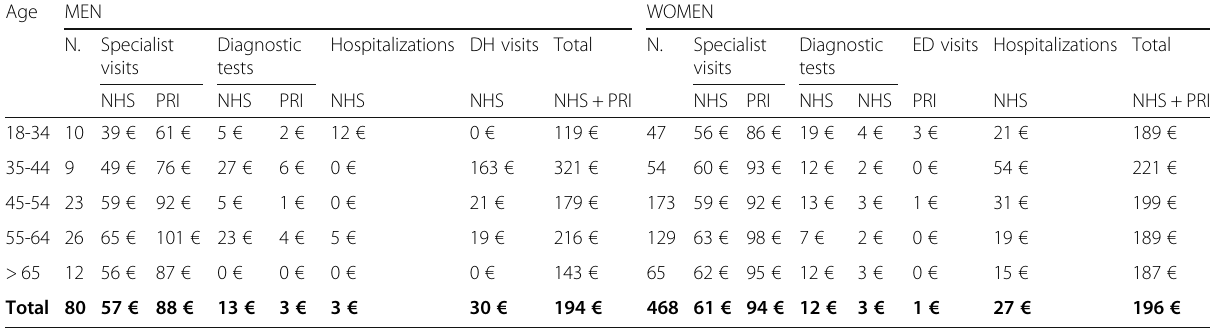
Table 3 Annual cost of specialist visits, diagnostic tests, hospitalizations and ED visits by gender, age and migraine status Age MEN WOMEN N. Specialist